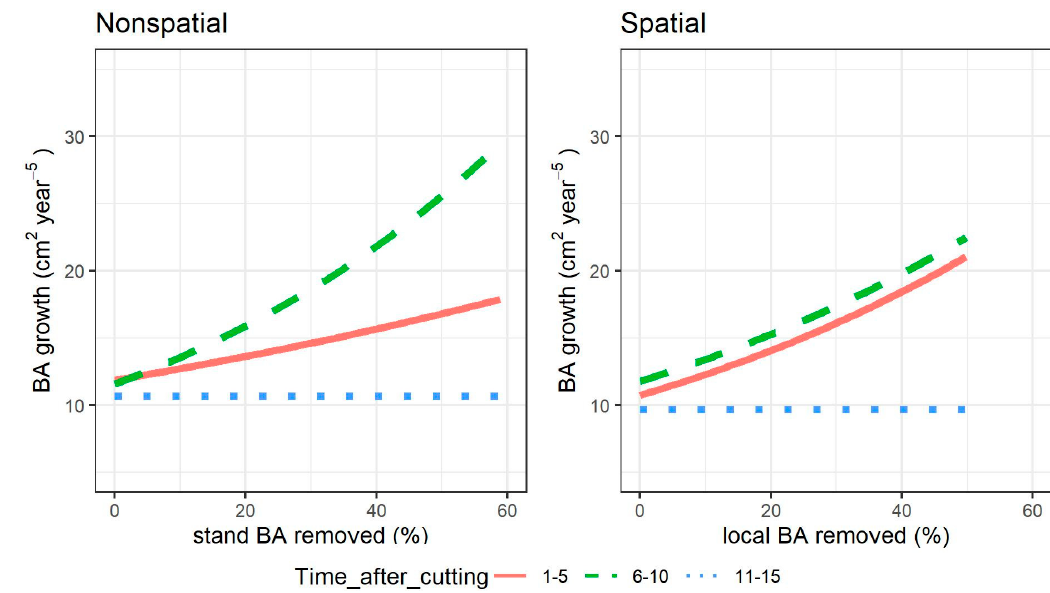
Figure 6. Individual tree growth response to single-tree selection cutting intensity, measured as percentage of basal area (BA) removed relative to levels prior the cutting, for different times after cutting and models. In the nonspatial model, cutting intensity is calculated at stand level, in the spatial model for the local 200 m 2 neighborhood around the subject tree. The lines show the growth of a tree of average height (9 m), when growing either 1–5 years after cutting ( continuous line ), 6–10 years after ( dashed line ), or 11–15 years ( dotted line ).